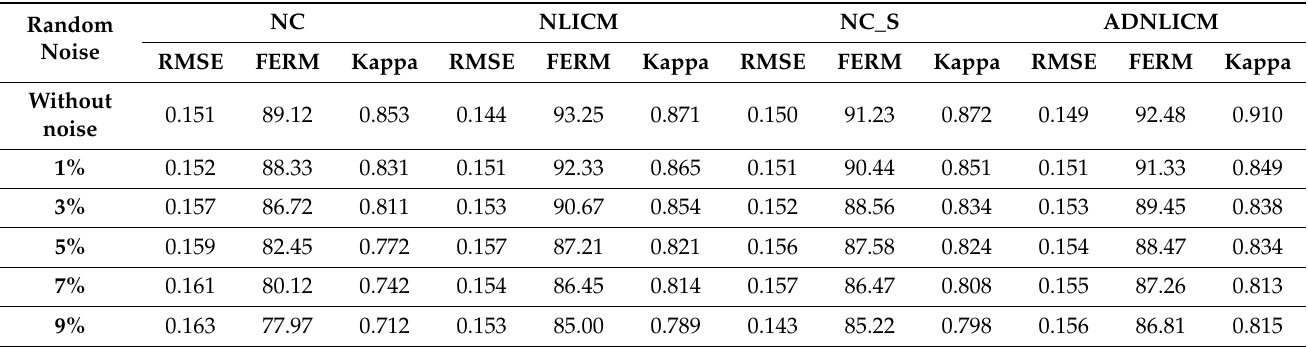
Table 13. RMSE, FERM, and Kappa for each algorithm with different random noise (pepper) for site 2 (Banasthali).